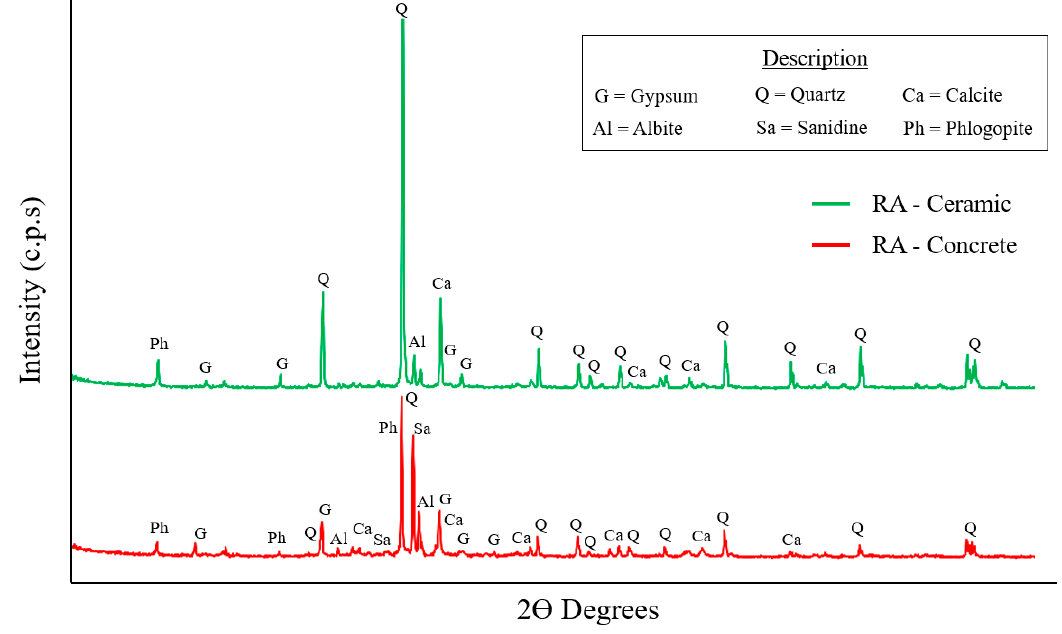
Figure 4. Diffractogram corresponding to the recycled ceramic aggregate and the recycled concrete aggregate.